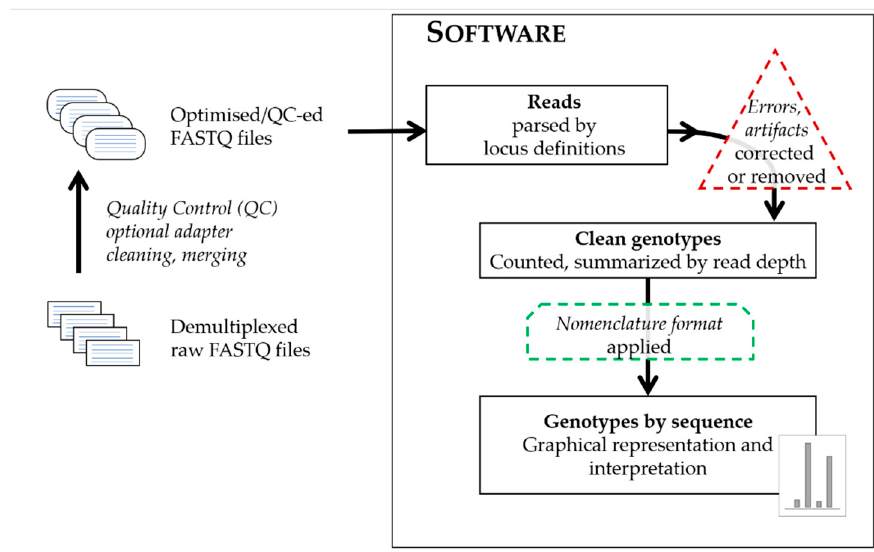
Figure 1. Schematic representation of general forensic MPS data processing steps.